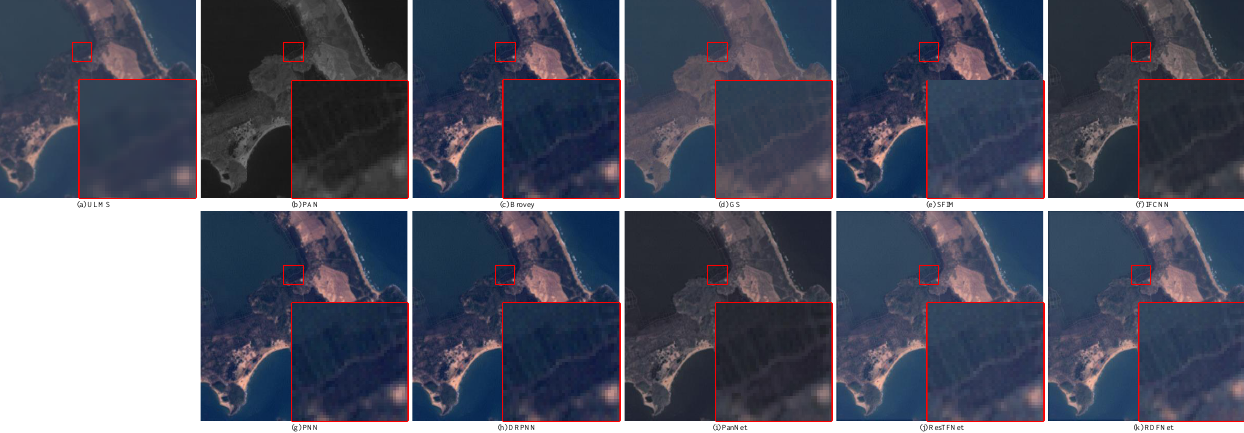
Figure 30. Subjective comparison between RDFNet and the current mainstream fusion methods for fusion results on the Landsat-7 testing dataset with full resolution. ( a ) ULMS; ( b ) PAN; ( c ) Brovey; ( d ) GS; ( e ) SFIM; ( f ) IFCNN; ( g ) PNN;